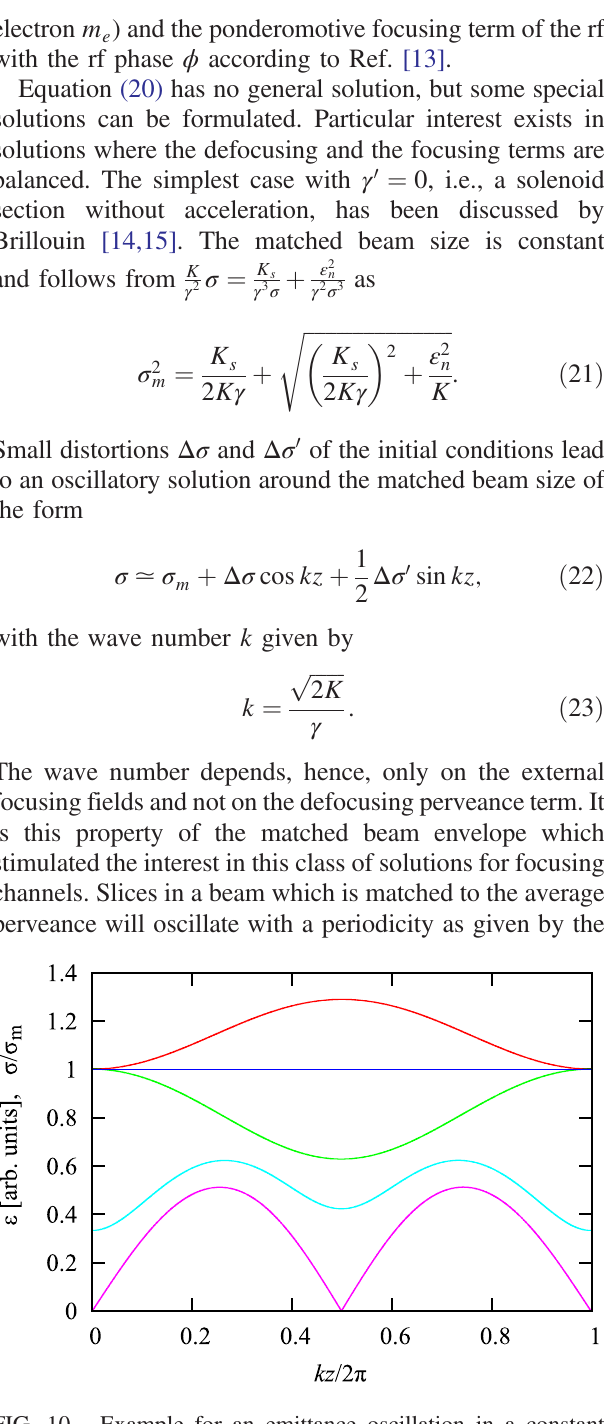
FIG. 10. Example for an emittance oscillation in a constant focusing channel. The average beam size (blue curve) is matched according to Eq. (21). It stays hence constant, while two slices (red and green curves) in the beam and hence also the beam emittance (cyan curve) oscillate due to the difference in the perveance. After half a period, a local emittance minimum is reached. Here the emittance is given by the beam size mismatch [cf. Eq. (16)]; only when the slice emittance is ignored (magenta curve) is a full emittance compensation already reached at this